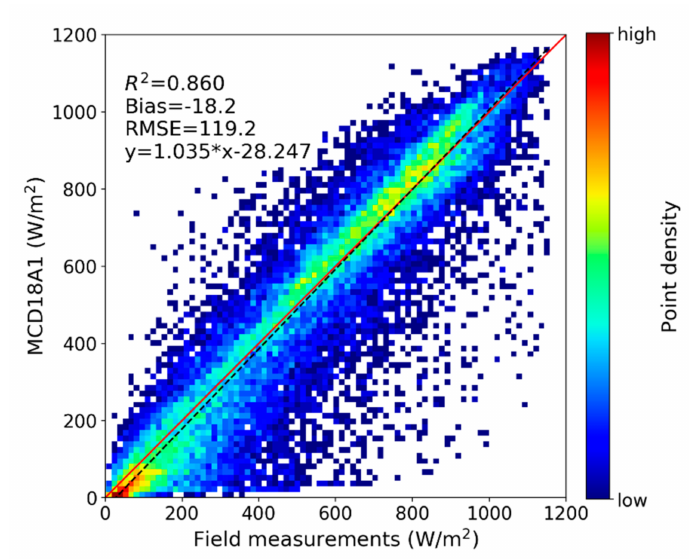
Figure 2. Validation results of all the MCD18A1 instantaneous DSR products using the BSRN 2018 measurements. The red solid line is the 1:1 line. The blacked dashed line is the regression line from robust regression and the regression formula is shown in the figure. The color in this density scatter plot represents the point density, and the following density scatter plots have the same color scheme.